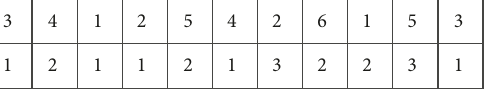
Figure 3: Scheme of a solution.